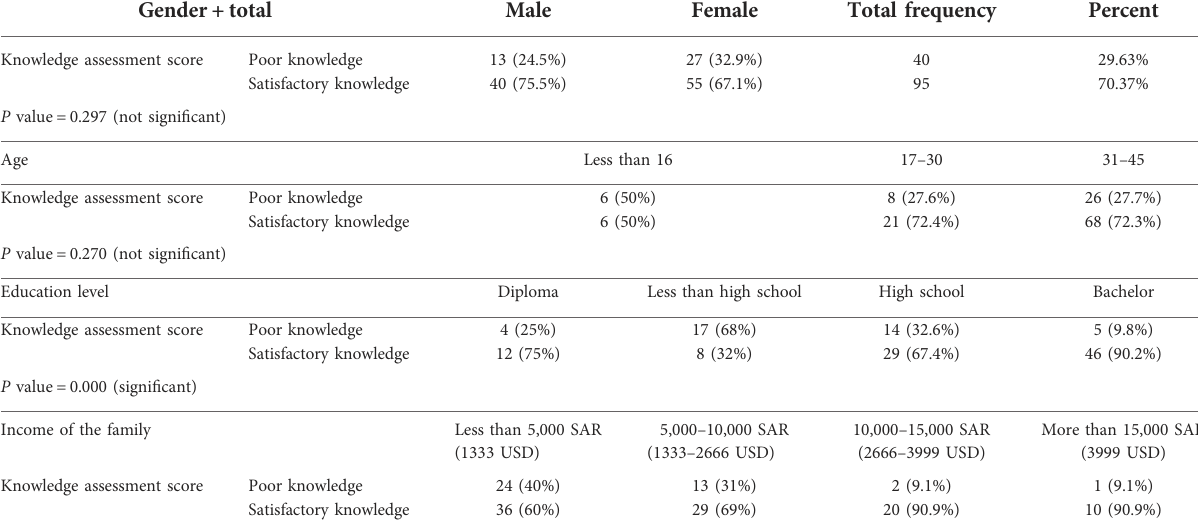
TABLE 5 Assessment of TRI and FP knowledge/awareness among cancer